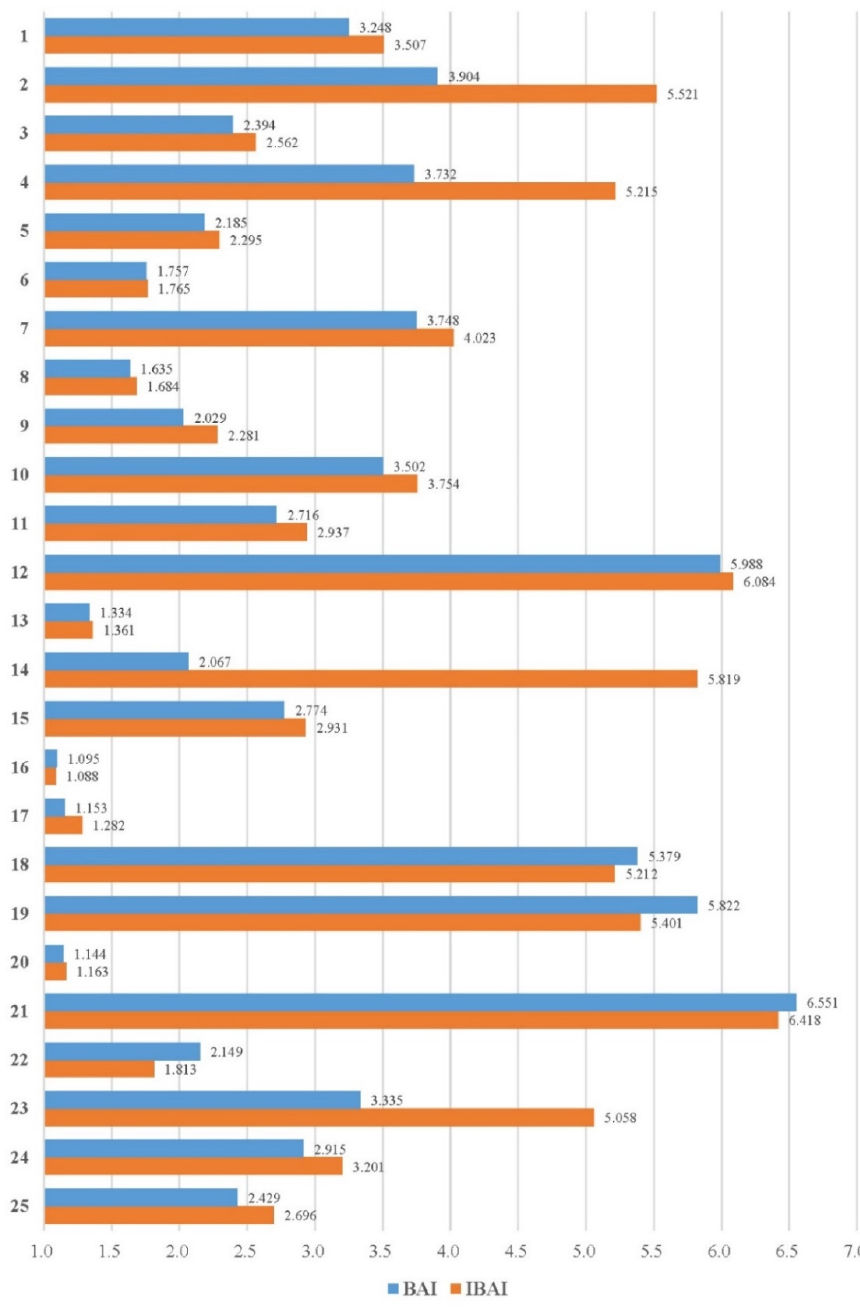
Figure 12. The result of the questionnaires.